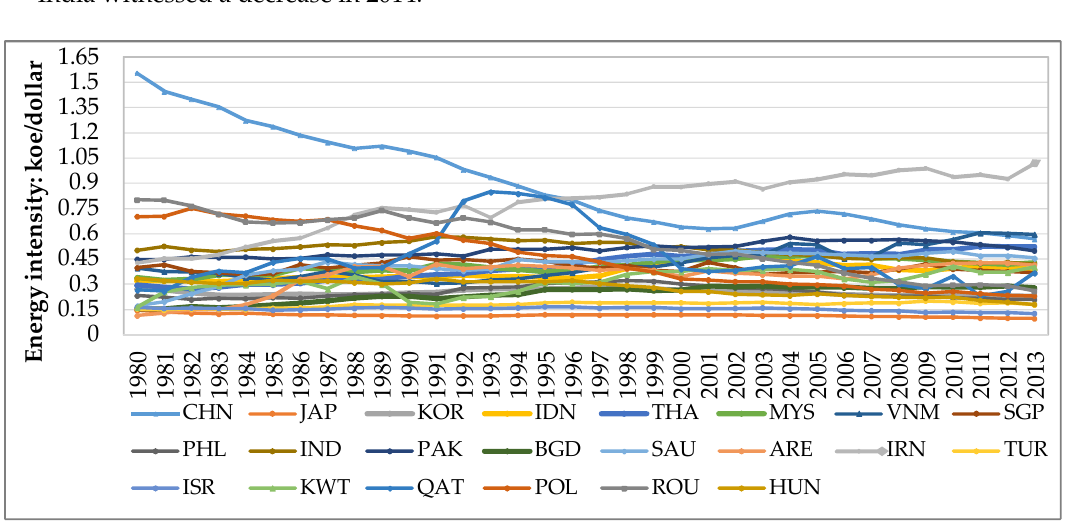
Figure 7. Energy intensities in 22 major B&R countries during 1980–2013. Figure 6. Energy intensities in 22 major B&R countries during